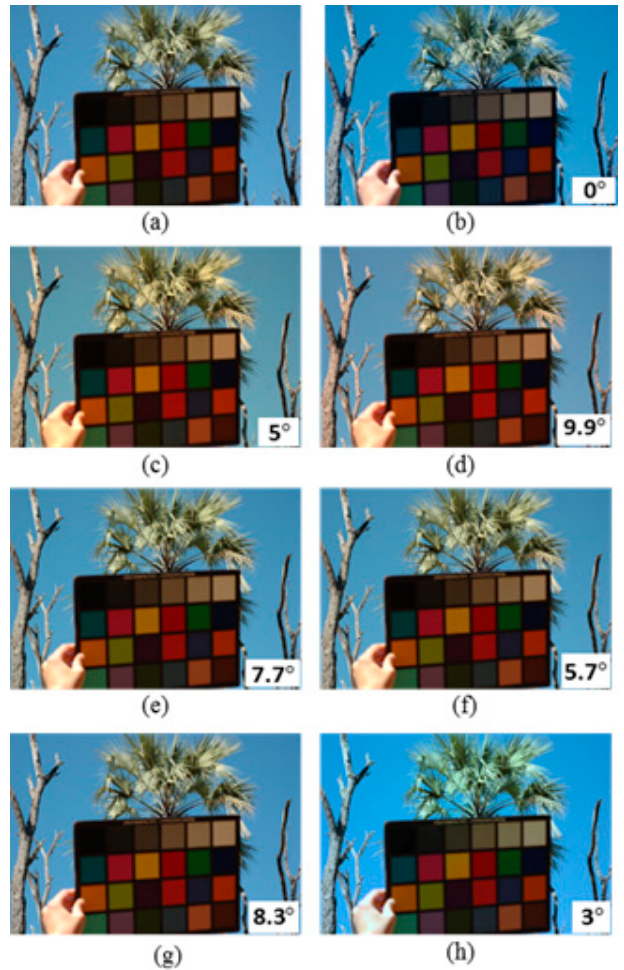
Figure 3. Original, ground truth and its colour-balanced images using different colour correction methods: ( a ) Original image from the UPenn Natural Image dataset [50], ( b ) Ground truth, ( c ) Max-RGB, ( d ) Shades of Grey, ( e ) Grey Edge-1, ( f ) Grey Edge-2, ( g ) Weighted Grey Edge and ( h ) Proposed CCAFIS’ methods’ images.